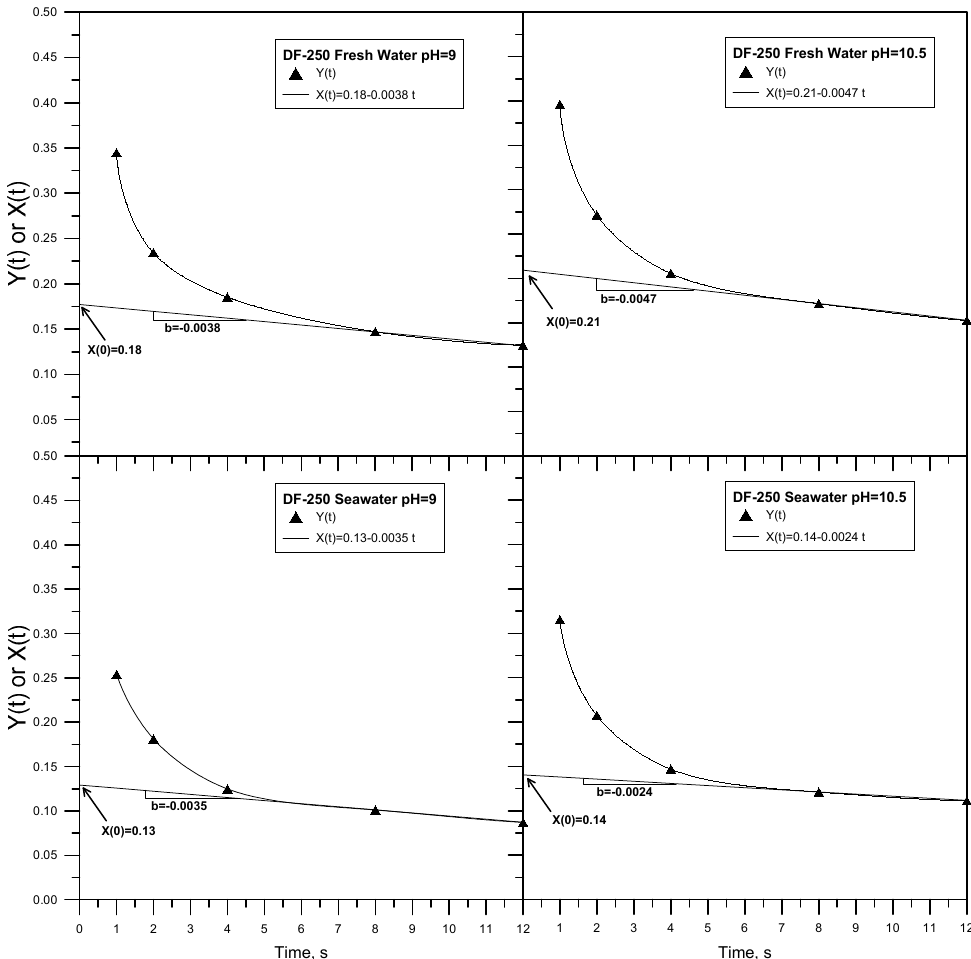
Figure 6. Y(t) and X(t) as a function of time. The tests were done in fresh and seawater, at pH 9 and 10.5, and using DF-250. Table 2. Constants of Method 3 for MIBC and DF-250 at different pH, and in fresh and seawater.